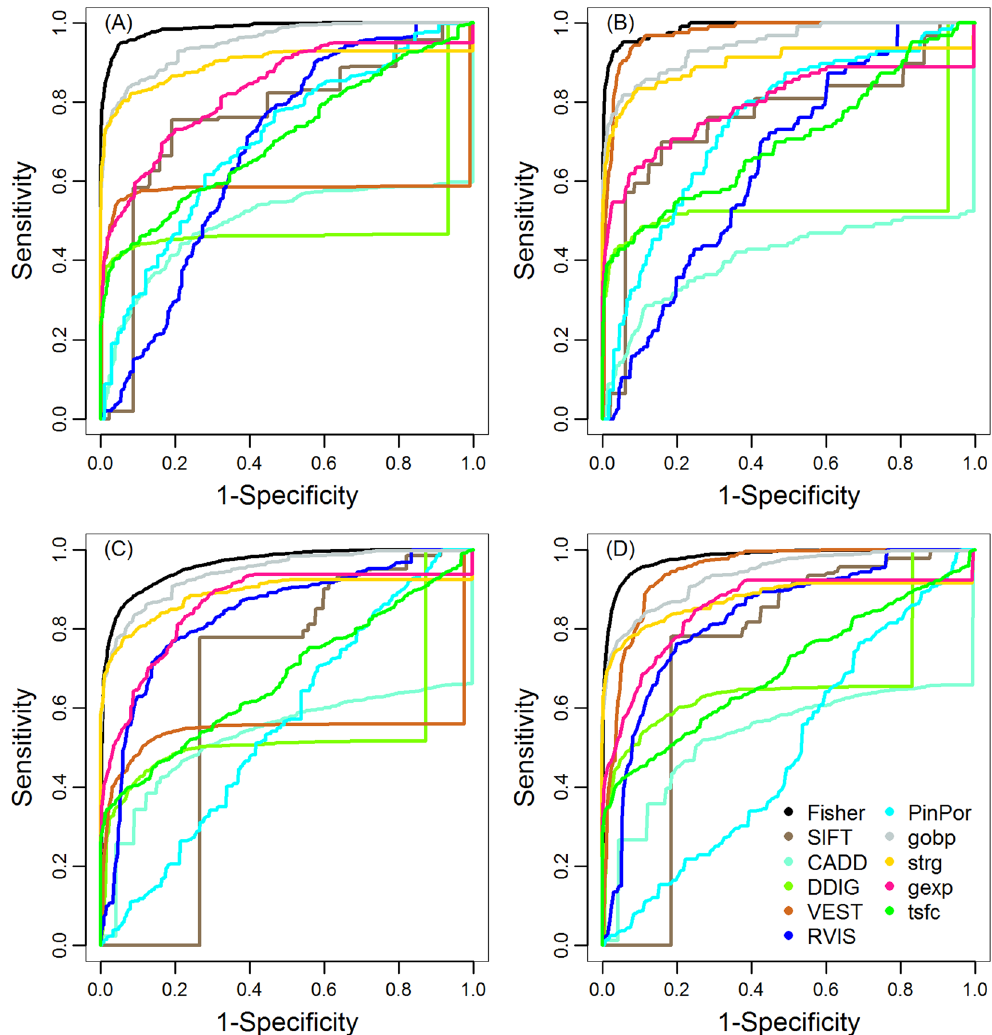
nonframeshift deletion; ( B ) nonframeshift insertion; ( C ) frameshift deletion; ( D ) frameshift